Question: Does the plotted quantity increase or decrease?
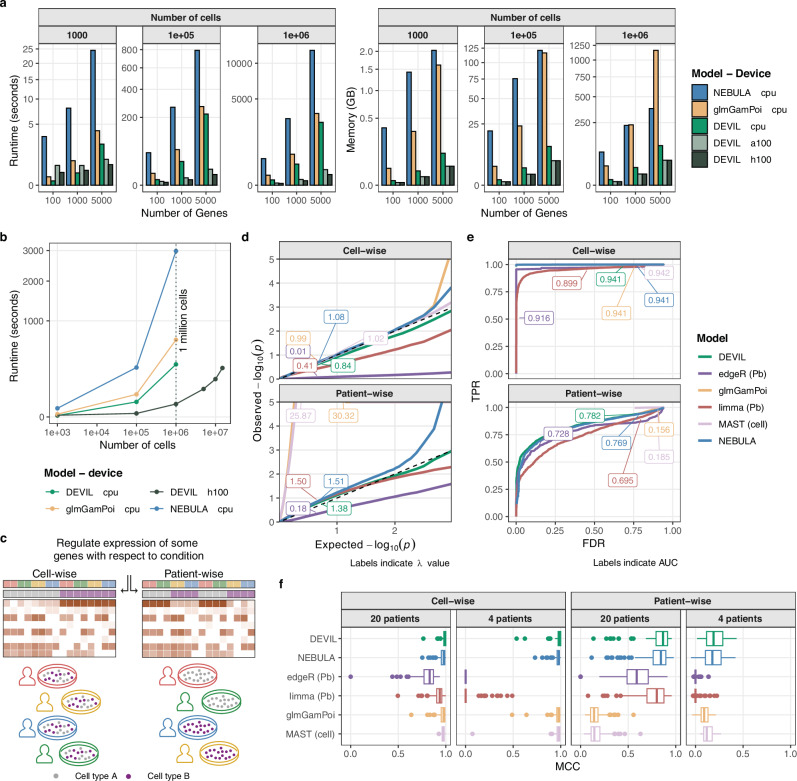
Answer: increasing